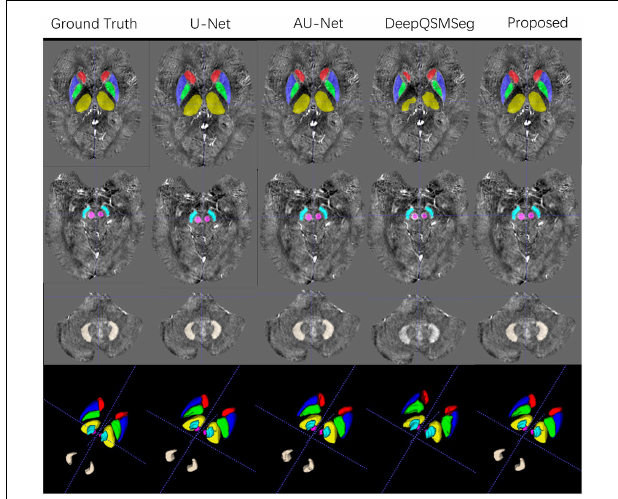
FIGURE 8 | Visualized examples of the segmentations of manual delineation, U-Net, AU-Net, DeepQSMSeg, and our proposed method on Dataset II. The segmentation results were overlaid on QSM images.